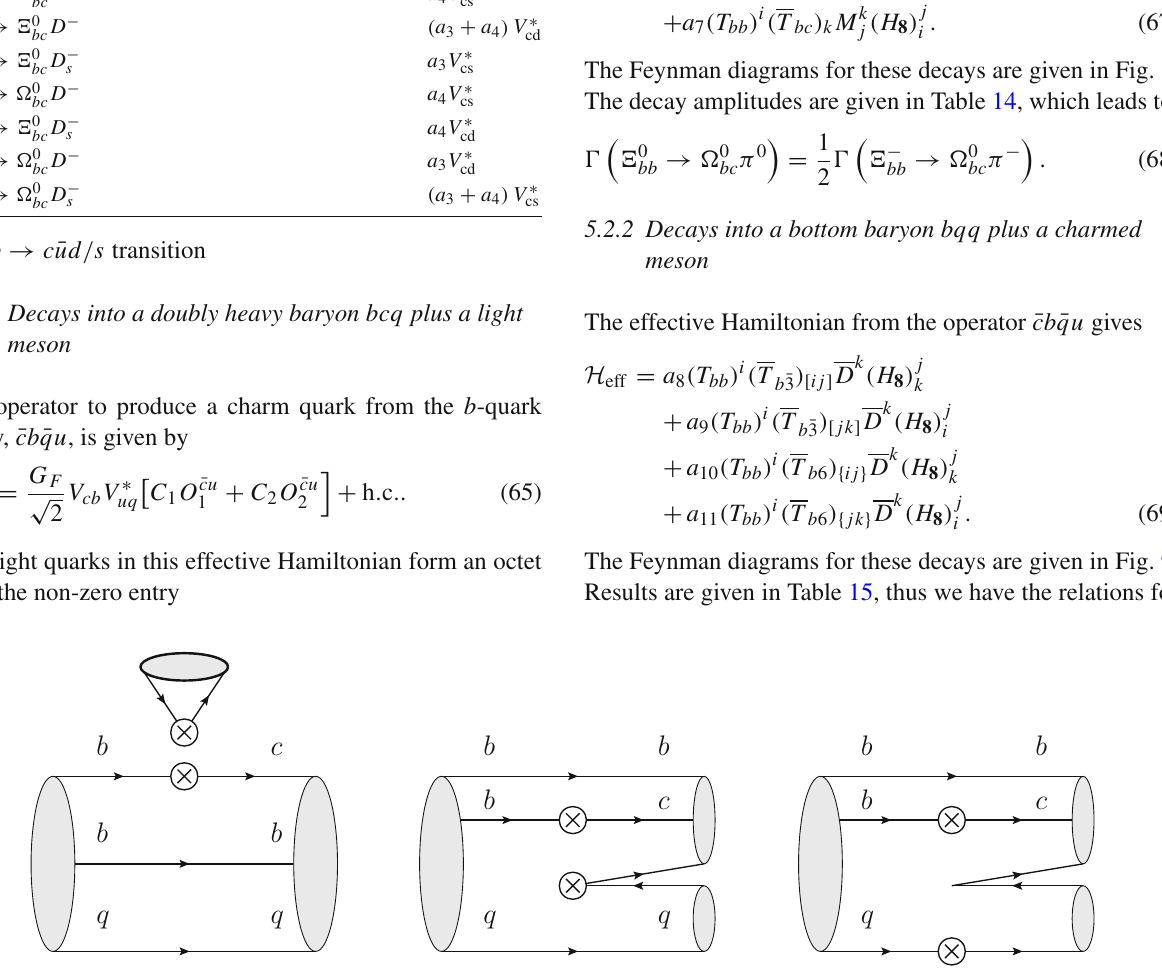
Fig. 8 The Feynman diagrams for (cid:2) bb and (cid:5) bb decays into a doubly heavy baryon and a light meson Table 14 Doubly bottom baryons decays into a bcq and a light meson